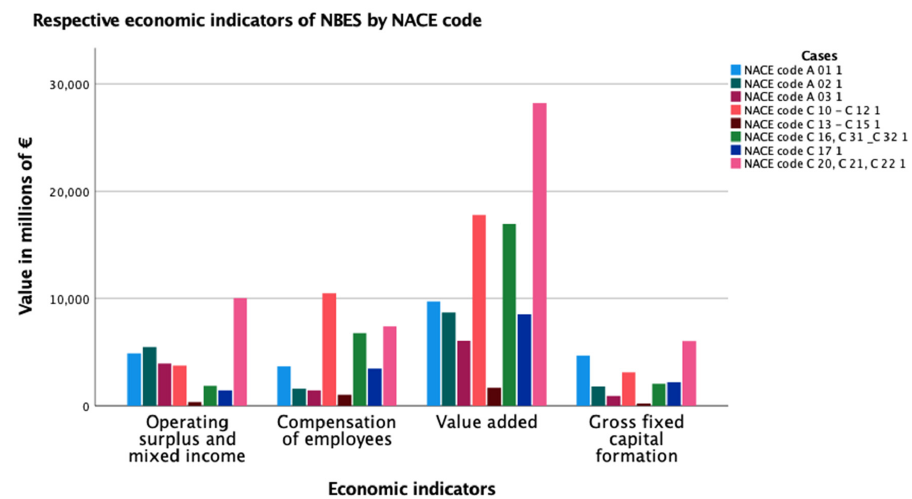
Figure 5. Economic performance indicators of Nordic Bioeconomy Sectors (NBES) by NACE code (Data: Eurostat 2021b).